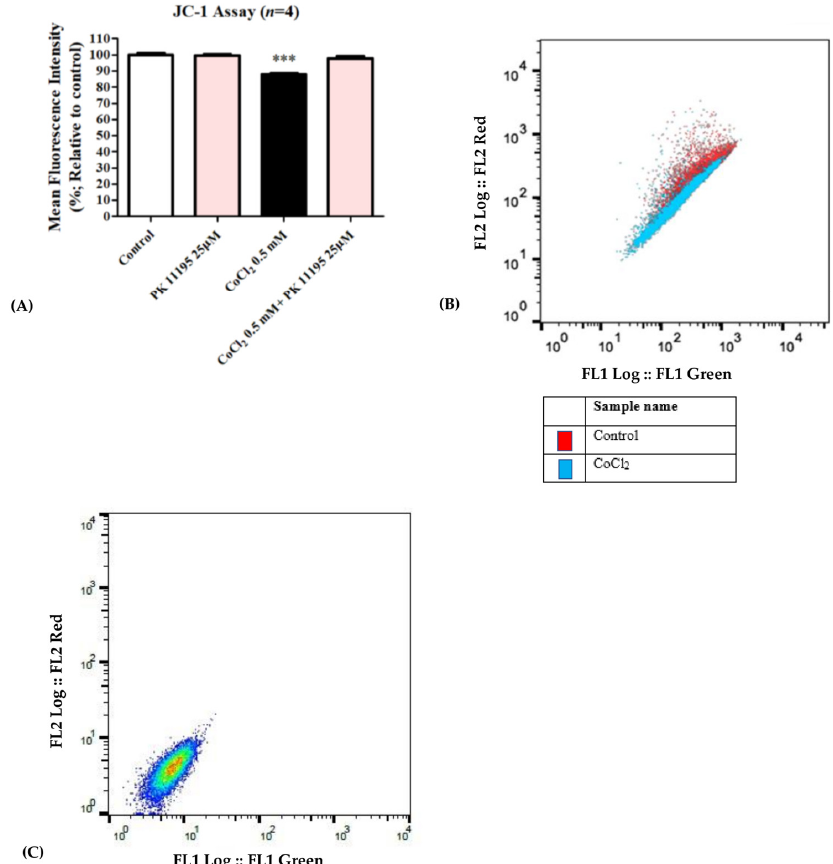
Figure 4. Assessment of mitochondrial membrane potential (JC-1) following exposure of H1299 for 24 h to 0.5 mM CoCl 2 . Inhibition of CoCl 2 -induced mitochondrial membrane potential depolarization by 25 µM PK 11195 expressed as ( A ) a bar graph, and ( B ) Representative of histogram ( C ) Representative of histogram from FlowJo. Results are expressed by means ± SD ( n = 4 replicates in each group). *** p < 0.001.